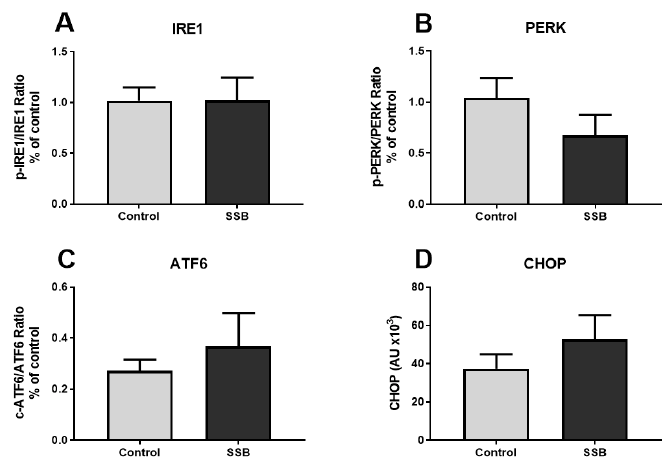
Figure 1. The effect of sugar-sweetened beverage (SSB) consumption on known markers of endoplasmic reticulum (ER) stress. ( A ) Inositol requiring enzyme 1 (IRE1), ( B ) PKR-like-eukaryotic initiation factor 2 alpha kinase (PERK), ( C ) activating transcription factor 6 (ATF6), and ( D ) C/EBP homologous protein (CHOP). Data are displayed as mean ± SEM ( n = 8).